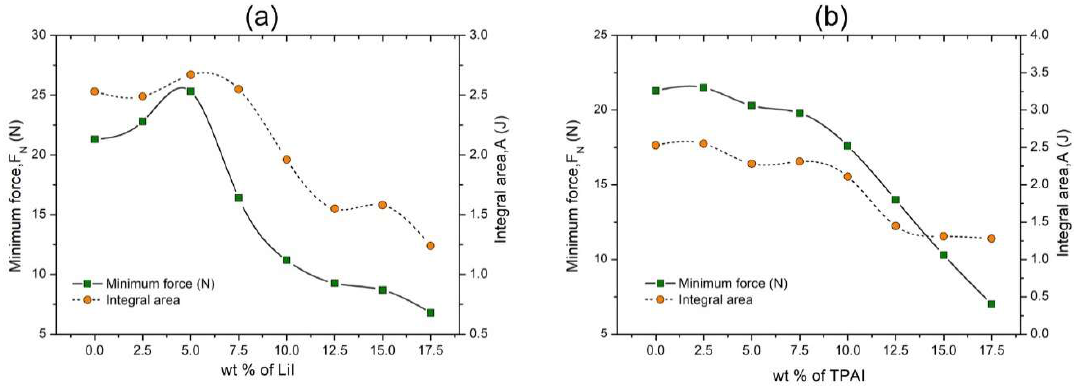
Figure 4. Tack test parameters of PhSt-HEC-DMF gels with ( a ) LiI and ( b ) TPAI.